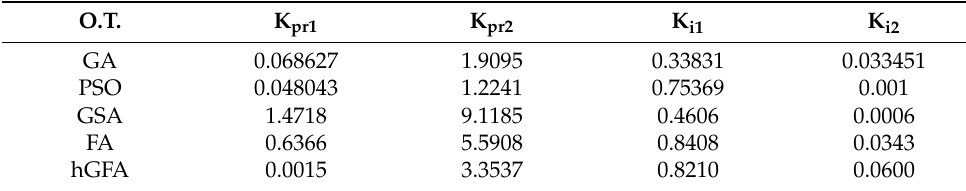
Table 1. Optimized parameters of PI controller for case